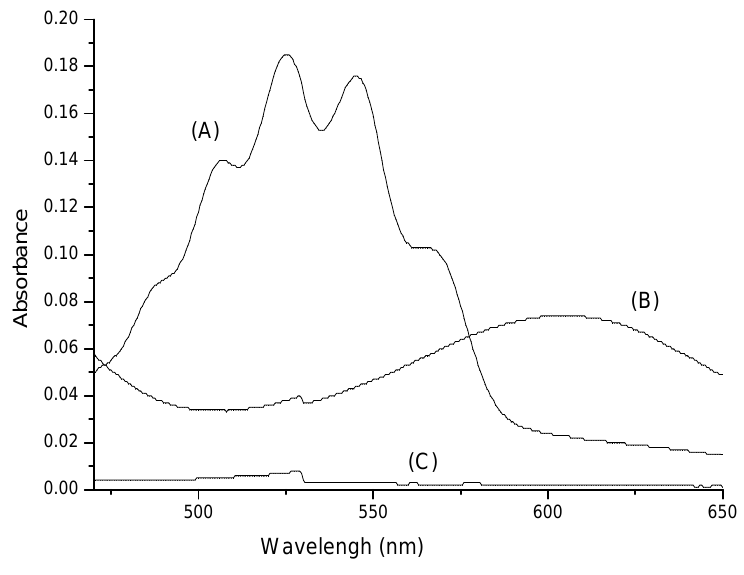
(B) KMnO + β -CD (C) β 4 4